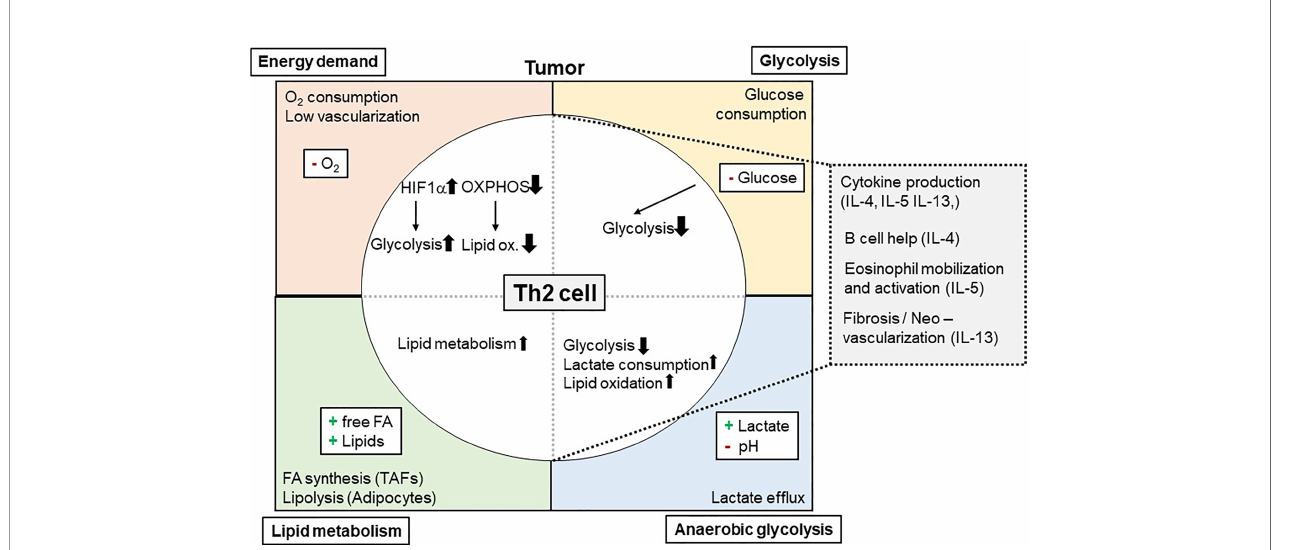
FIGURE 1 | Metabolic Interdependency of Th2 cell-mediated type 2 immunity and the Tumor Microenvironment (TME): The TME is characterized by a high energy demand, glycolysis, and lipid metabolism. This reduces 0 2 and glucose availability within the TME, while free FA, other lipids and lactate is found to be elevated. These conditions affect Th2 cells and their effector functions (e.g. cytokine production of IL-4, IL-5, and IL-13) and, secondary, eosinophil mobilization and activation. 0 2 , Oxygen; IL, Interleukin; Ox., Oxidation; FA, Fatty